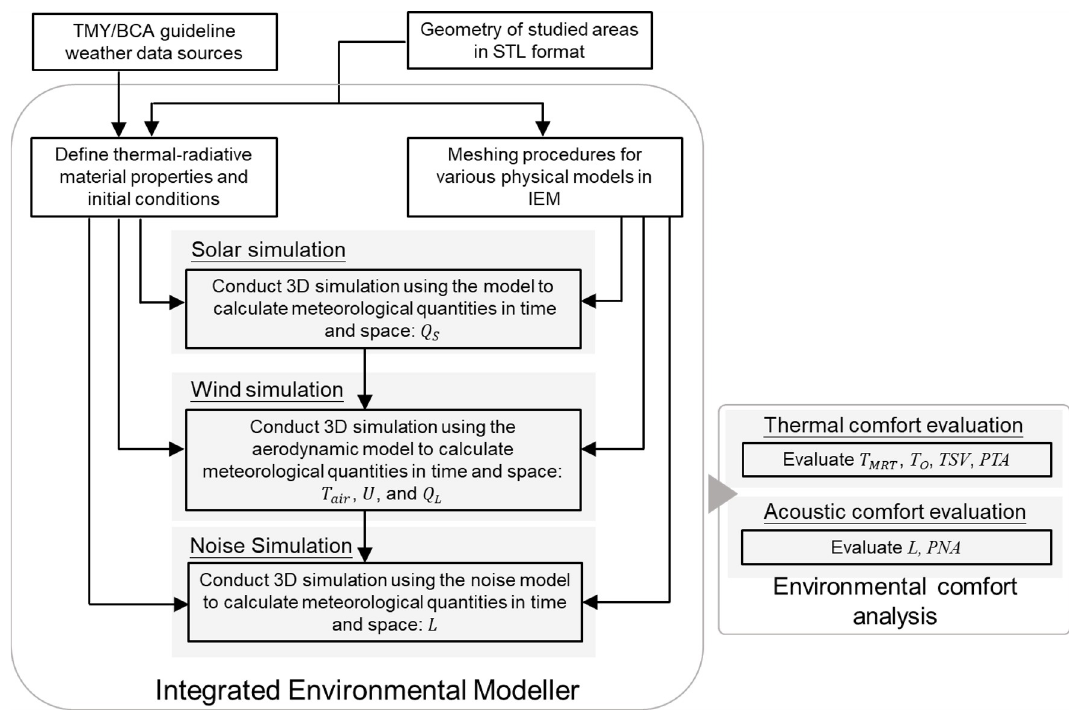
Fig 4. The flowchart represents the detailed research procedures in this